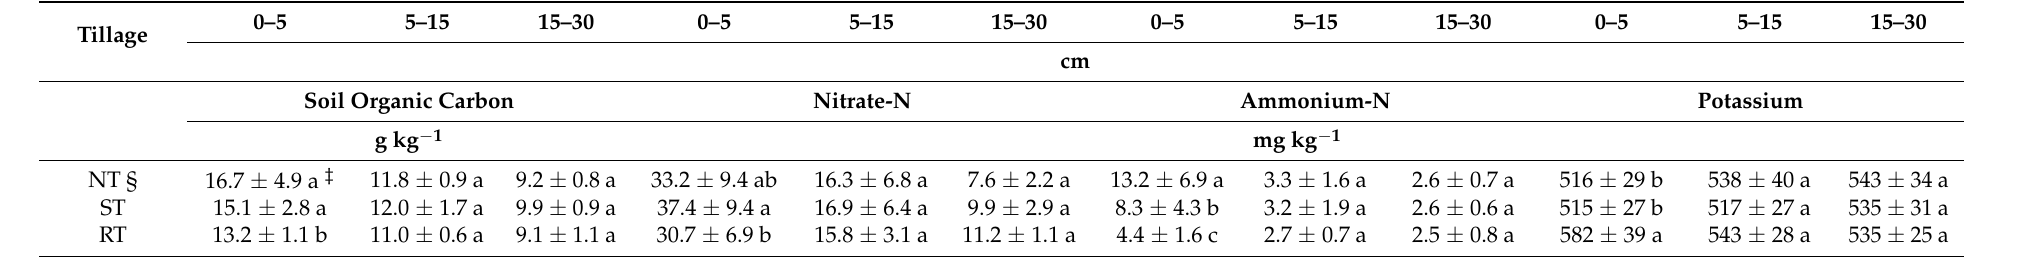
Table 4. Soil organic carbon, nitrogen (N), and potassium concentrations as affected by tillage operation and soil sampling depth.